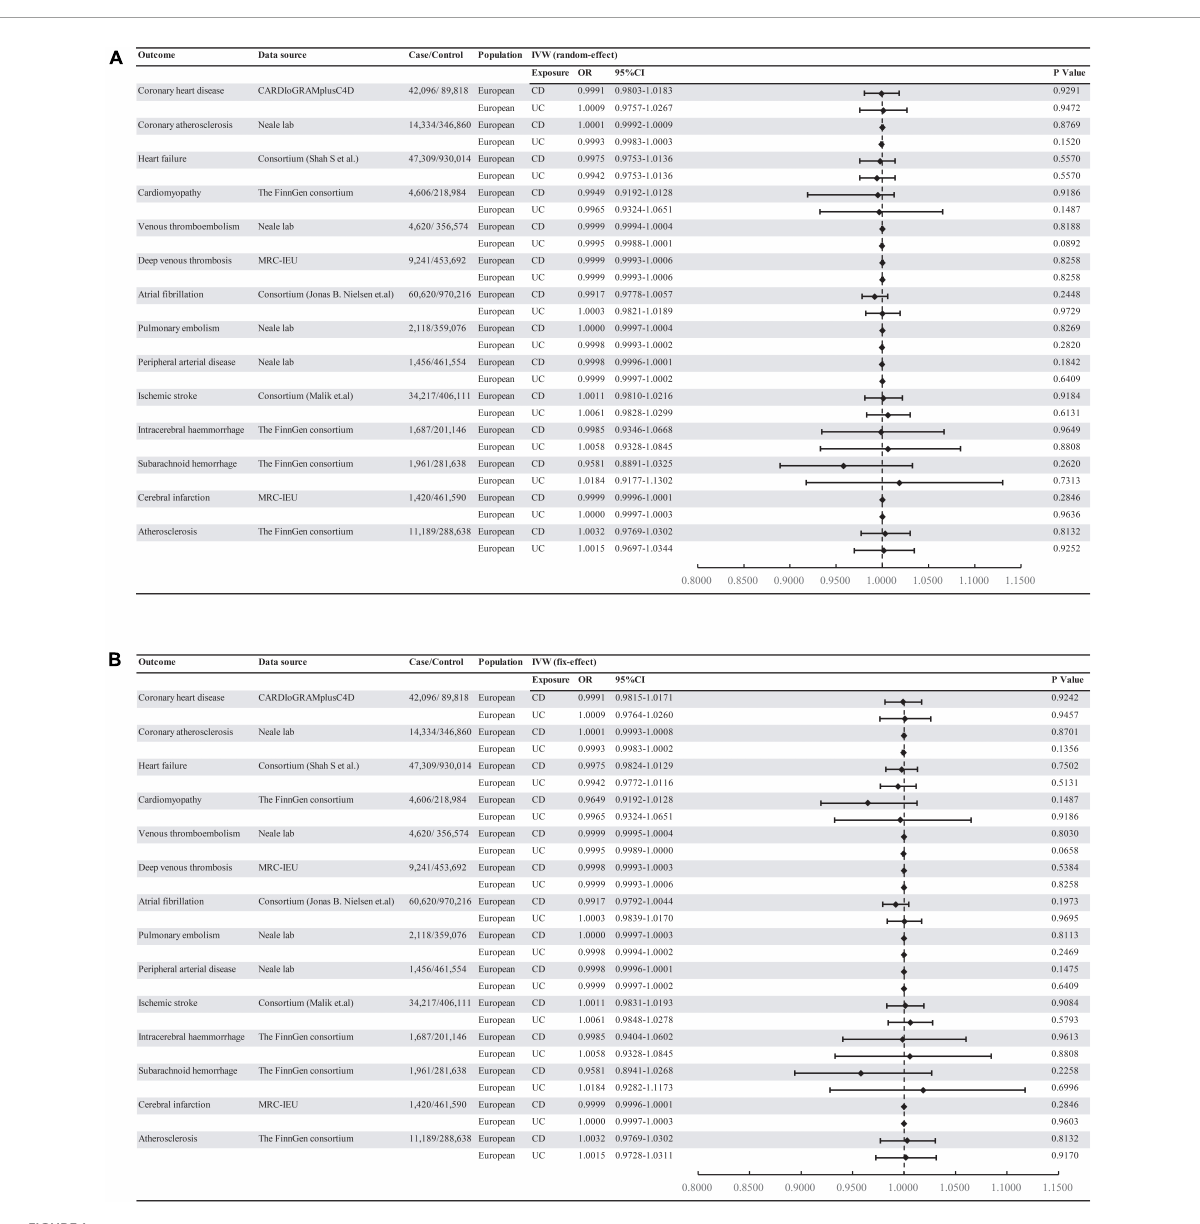
FIGURE1 Associations of genetically predicted IBD with risk of 14 CVD outcomes. (A) Random-effect. (B) Fix-effect. UC, ulcerative colitis; CD, Crohn’s disease; MRC-IEU: MRC Integrative Epidemiology Unit.